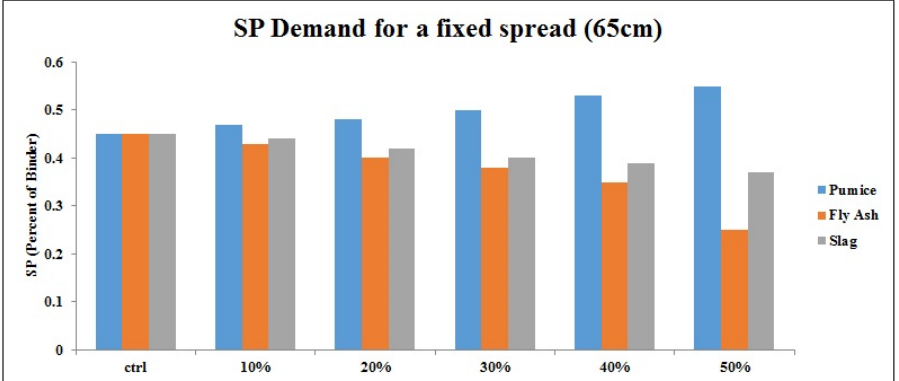
Figure 8. SP consumption of each replacement based on replacement percentage for a fixed slump value.